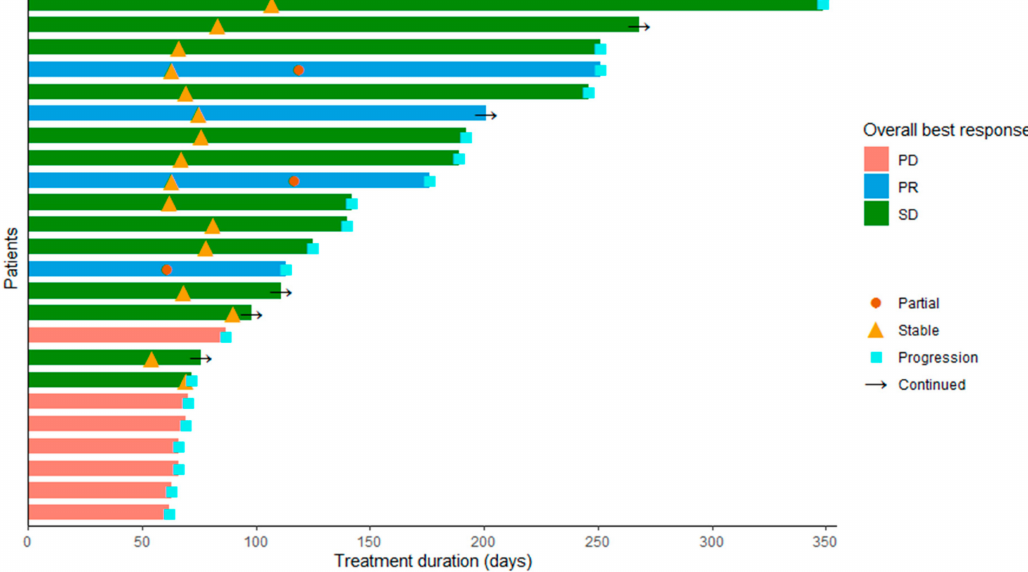
Figure 2. Swimmers plot for evaluation of progression and responses in days, responses as indicated phase I and II combined for the patients of phase I that received prior treatment with FOLFIRINOX and treatment with LDE225 200 mg. PD = progressive disease, PR = partial response, SD = stable